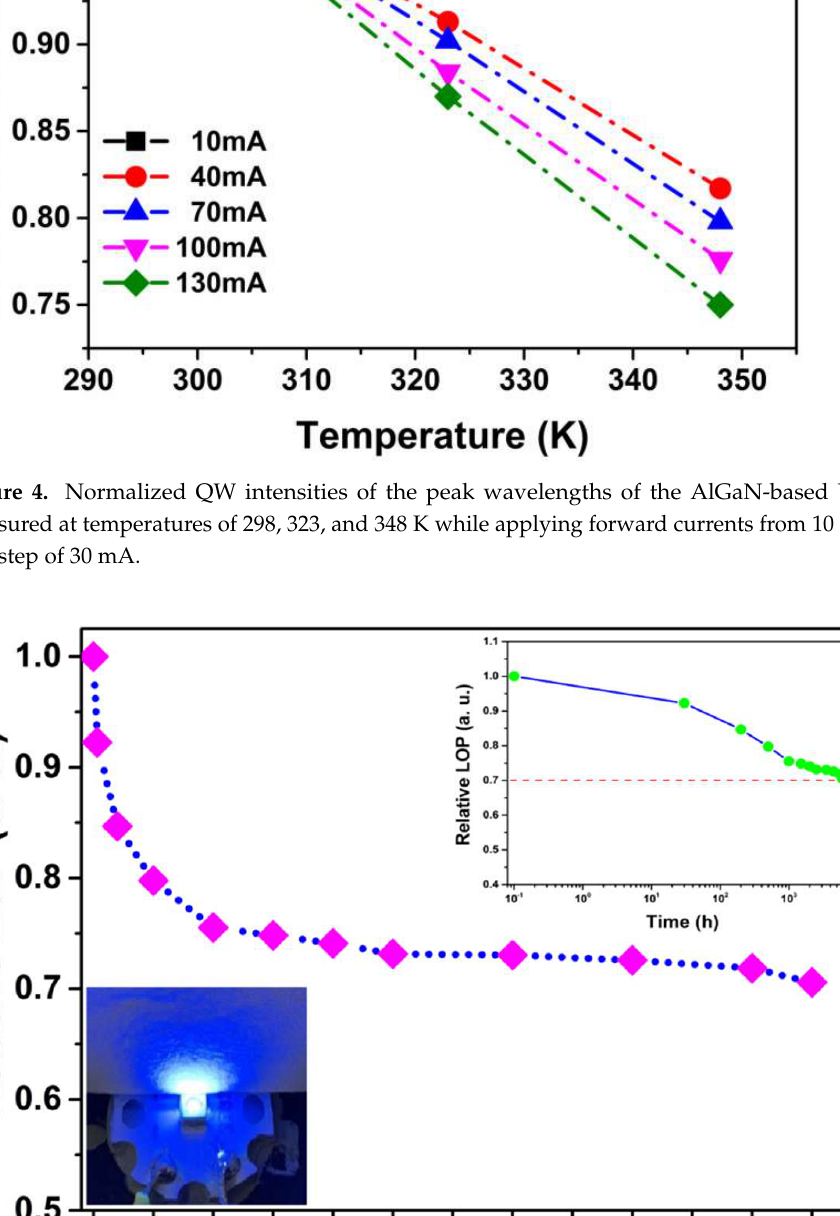
Figure 5. Relative LOP of the AlGaN-based UVB-LED, measured during aging tests performed at 40 mA. Insets: (left) photograph of the UVB-LED during operation; (right) LOP plotted on a logarithmic time scale.